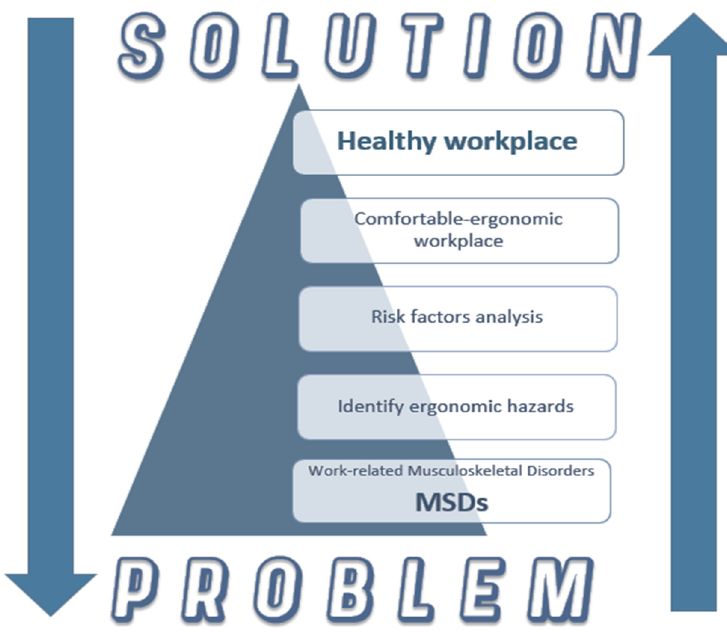
Figure 5. Overview of effect-cause relation of Healthy workplace and